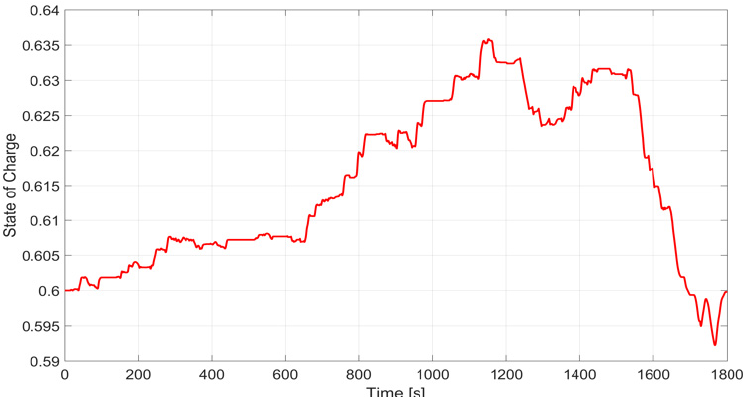
Figure 4. Optimal state of charge trajectory obtained through PMP on the WLTP driving cycle with Q = 2000.